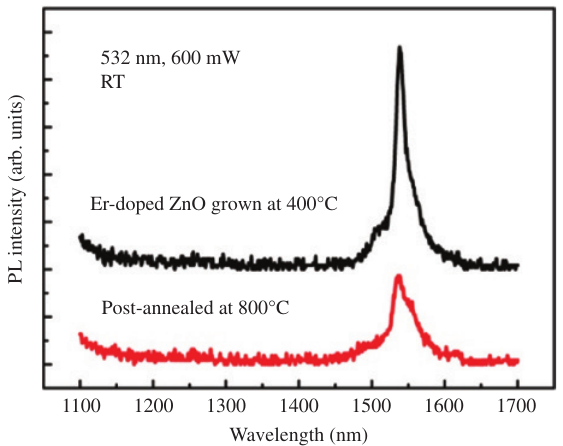
Figure 4: PL spectra of the as-deposited and post-annealed